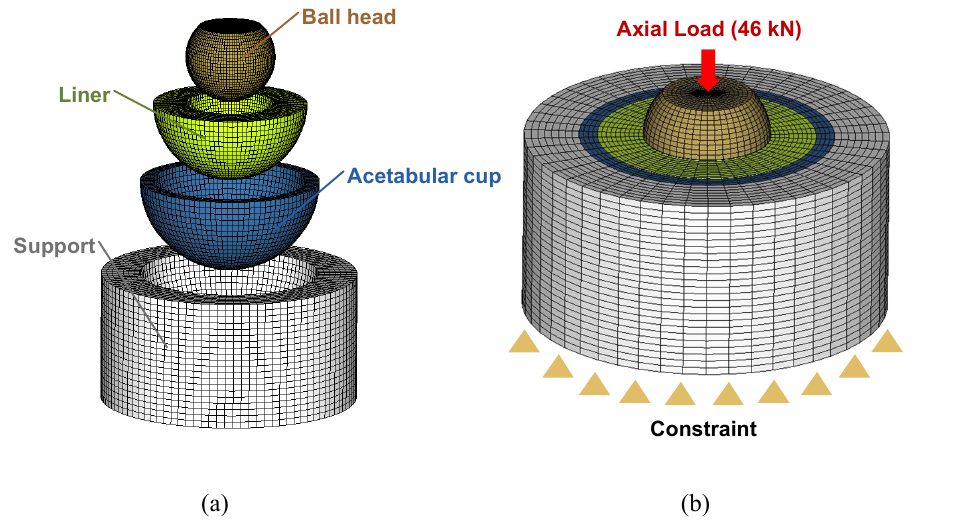
Fig. 2 Finite element models of acetabular components. (a) Acetabular components consisted of ball head, liner, acetabular cup, and support. (b) Load was applied to center of ball head (46 kN), while support was constrained.